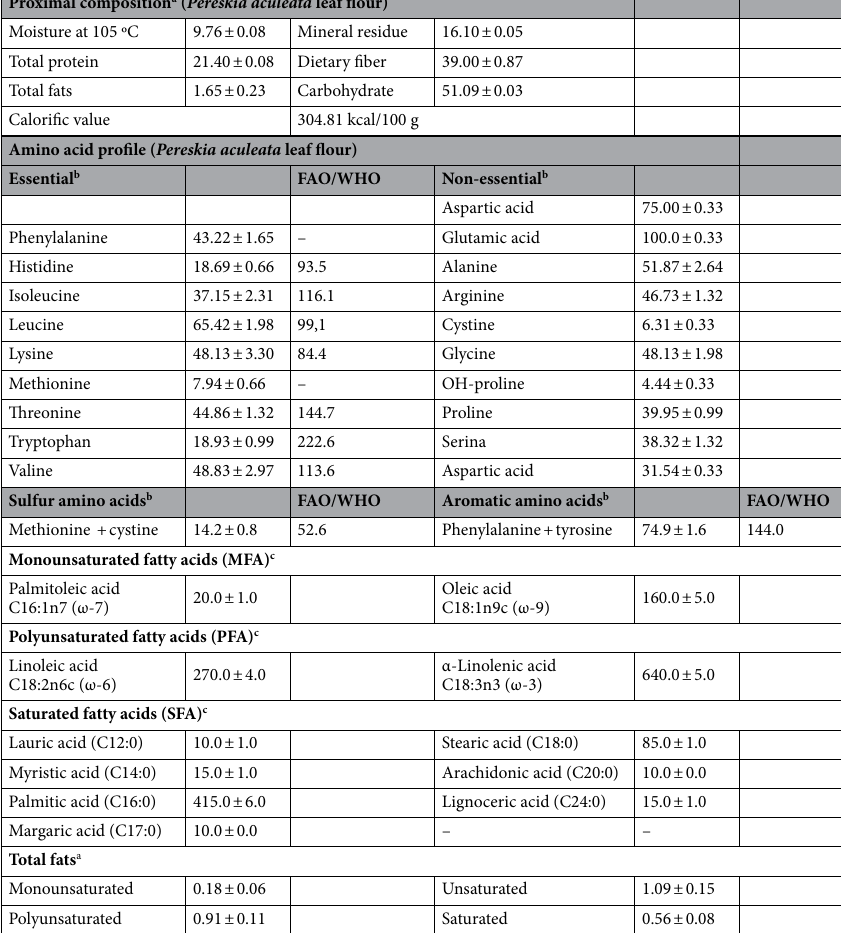
Table 2. Proximal and nutritional composition of Pereskia aculeata leaf flour. a g per 100 g of P. aculeata flour Agriculture Organization, and WHO: World Health